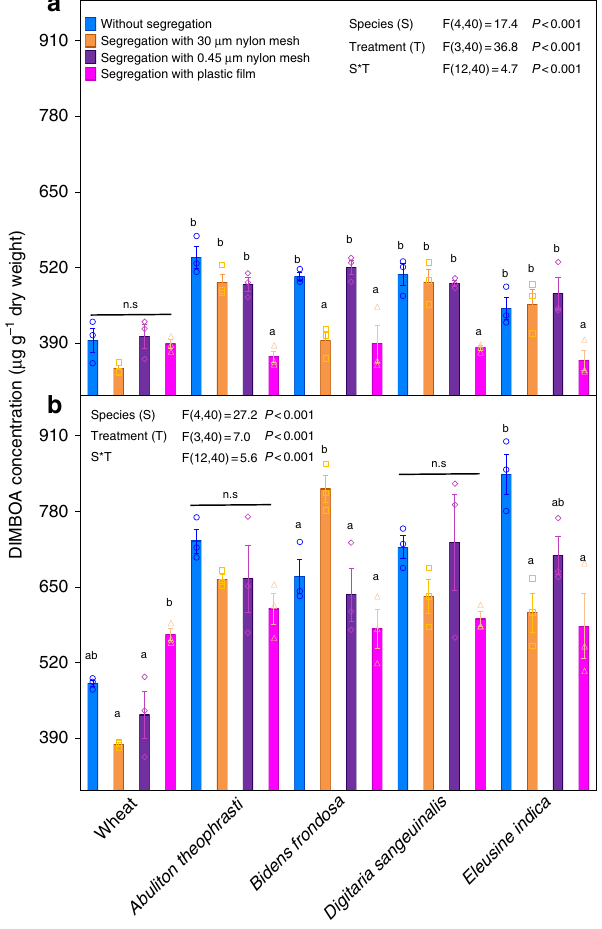
Fig. 3 Allelochemical response of wheat shoot and root to the presence of neighbors grown at a 5:5 mixture with various levels of belowground segregation. a Wheat shoot; b Wheat root. The effect of levels of belowground segregation and species identity on the concentration of allelochemical DIMBOA was tested using linear model with levels of belowground segregation and species as fi xed factors. Tukey post hoc tests were calculated between treatments of levels of belowground segregation. Values plotted are means ( n = 3) ± standard errors (SE). Columns with different letters indicate signi fi cant difference among treatments at P < 0.05. The error bar denotes 1